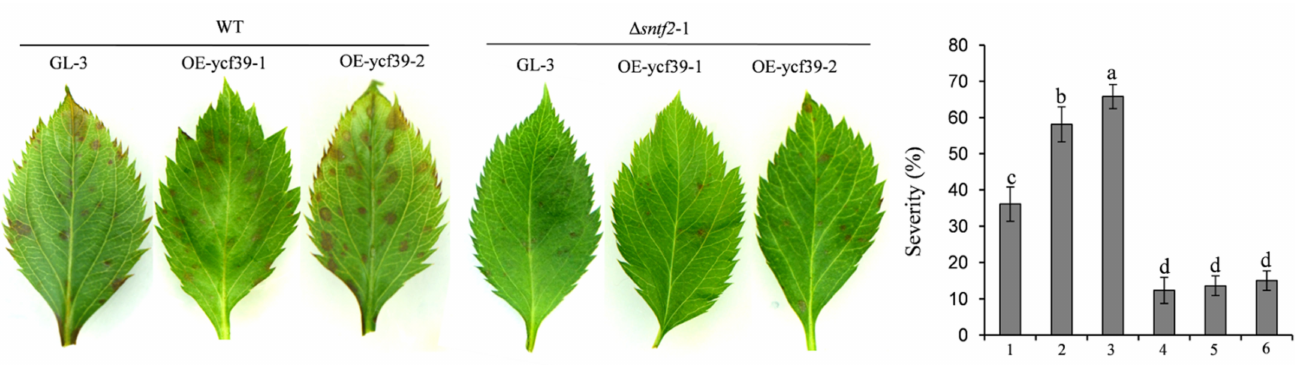
Figure 8. Analysis of the susceptibility of OE-ycf39 lines. The susceptibility was evaluated at three days after inoculation with WT and ∆ sntf2 -1 based on the disease index. 1–3: GL-3, OE-ycf39-1, and OE-ycf39-2 lines were inoculated with WT; 4–5: GL-3, OE-ycf39-1, and OE-ycf39-2 lines were inoculated with ∆ sntf2 -1. Three replicates were performed for each experiment, with six leaves for each replicate. Error bars represent standard deviations. Lowercase letters represent significant differences ( p <